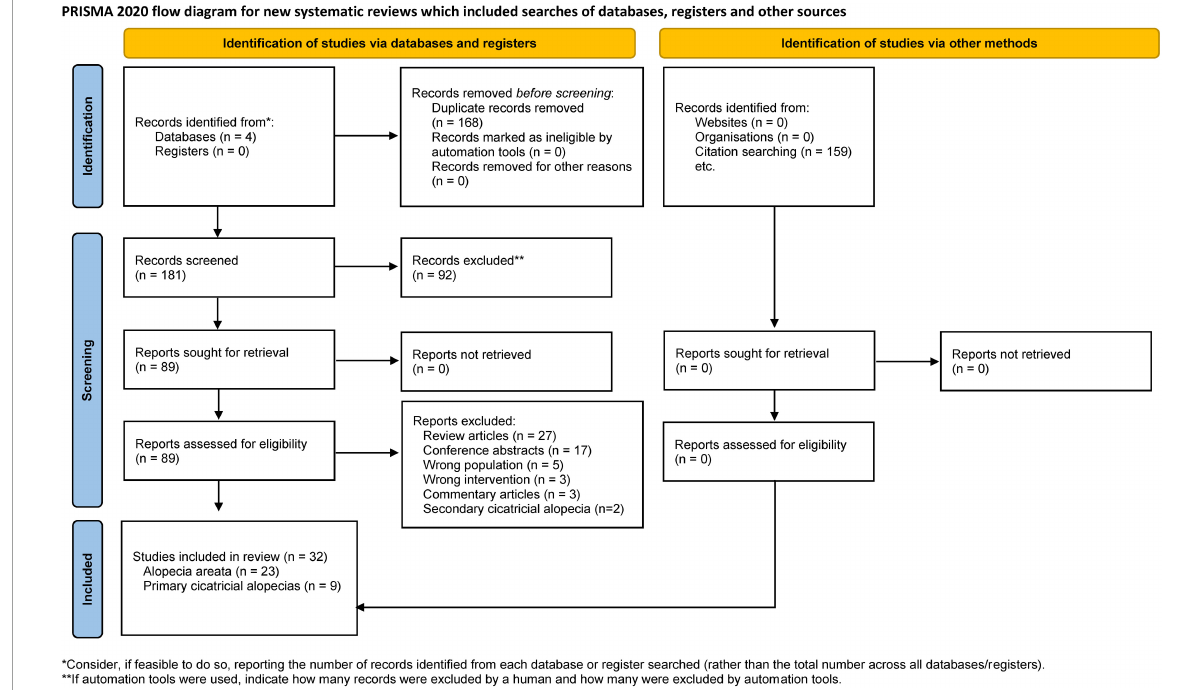
FIGURE1 Flow diagram of search methodology and selection process based on the preferred reporting items for systematic reviews and meta-analyses (PRISMA) flowchart for the article selection